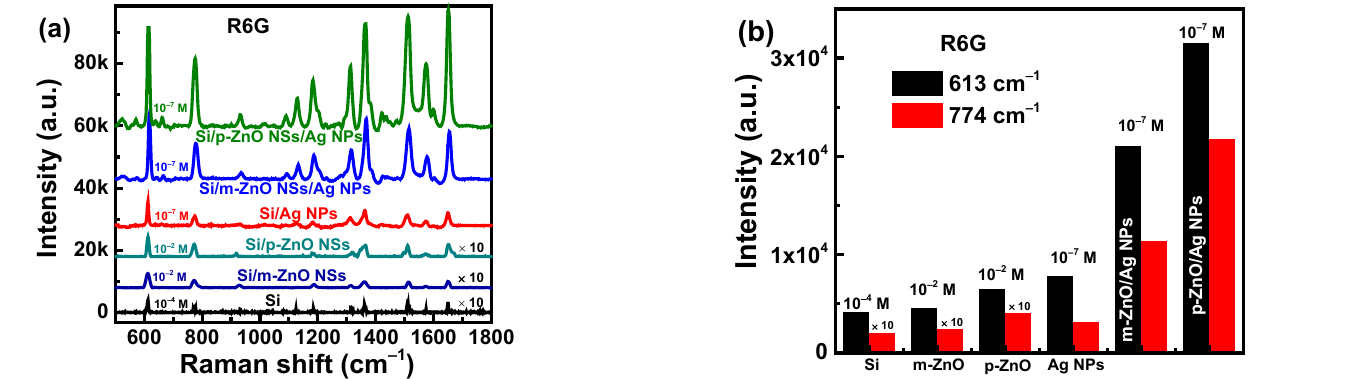
Figure 6. ( a ) Raman spectra of R6G with concentrations of 10 −7 M, 10 −4 M, or 10 −2 M for different substrates. ( b ) Corresponding Raman intensities of the 613 cm −1 and 774 cm −1 peaks for different substrates.